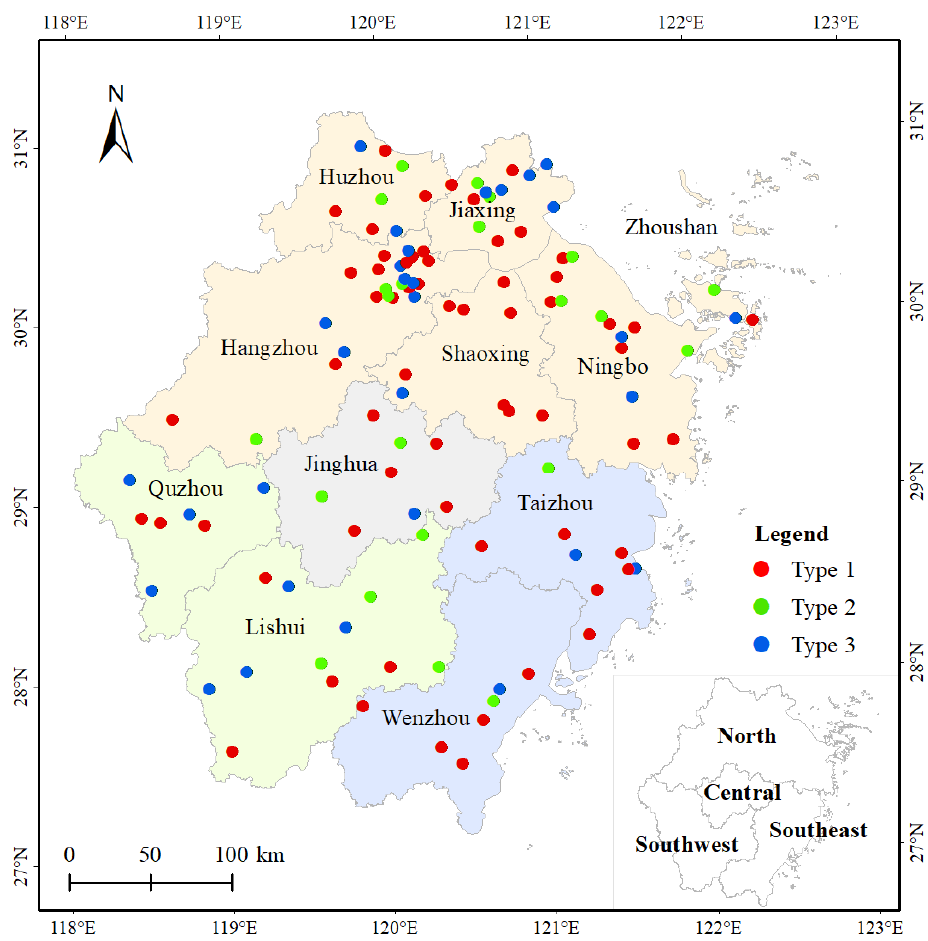
Figure 5. Spatial distribution of spatial spillover types of characteristic towns.